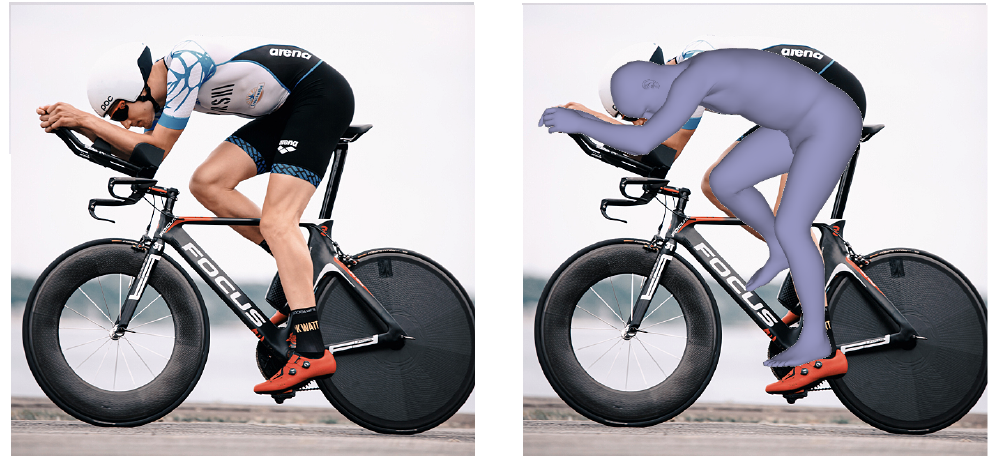
Figure 5. Machine learning algorithm ExPose shows the conversion from a 2D image to a 3D